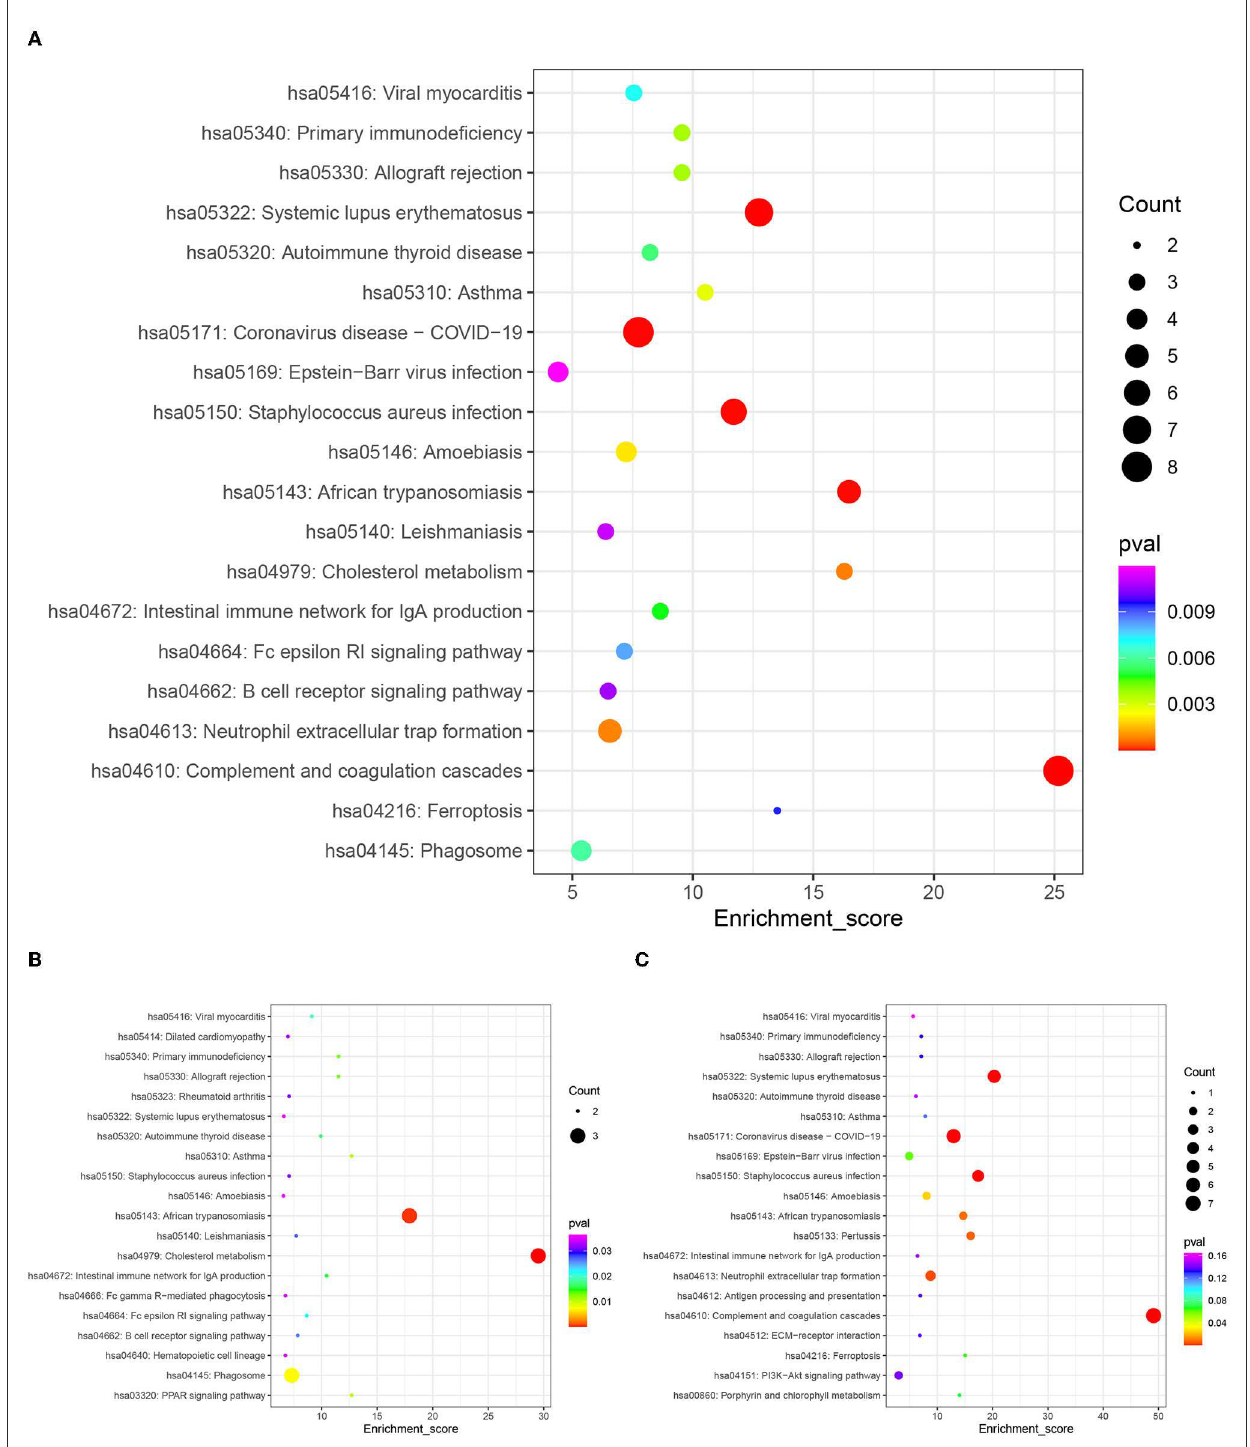
FIGURE5 KEGG enrichment top 20 bubble map. The x-axis Enrichment Score is the enrichment score and the y-axis is the pathway information of top 20 in the graph. The larger the bubble the more entries contain the number of differential proteins, the bubble color changes from red-green-blue-purple, and the smaller its enrichment p -value value, the greater the significance. (A) Top 20 KEGG pathways of all differentially expressed proteins. (B) Top 20 KEGG pathways of the up-regulated expressed proteins. (C) Top 20 KEGG pathways of the down-regulated expressed proteins.